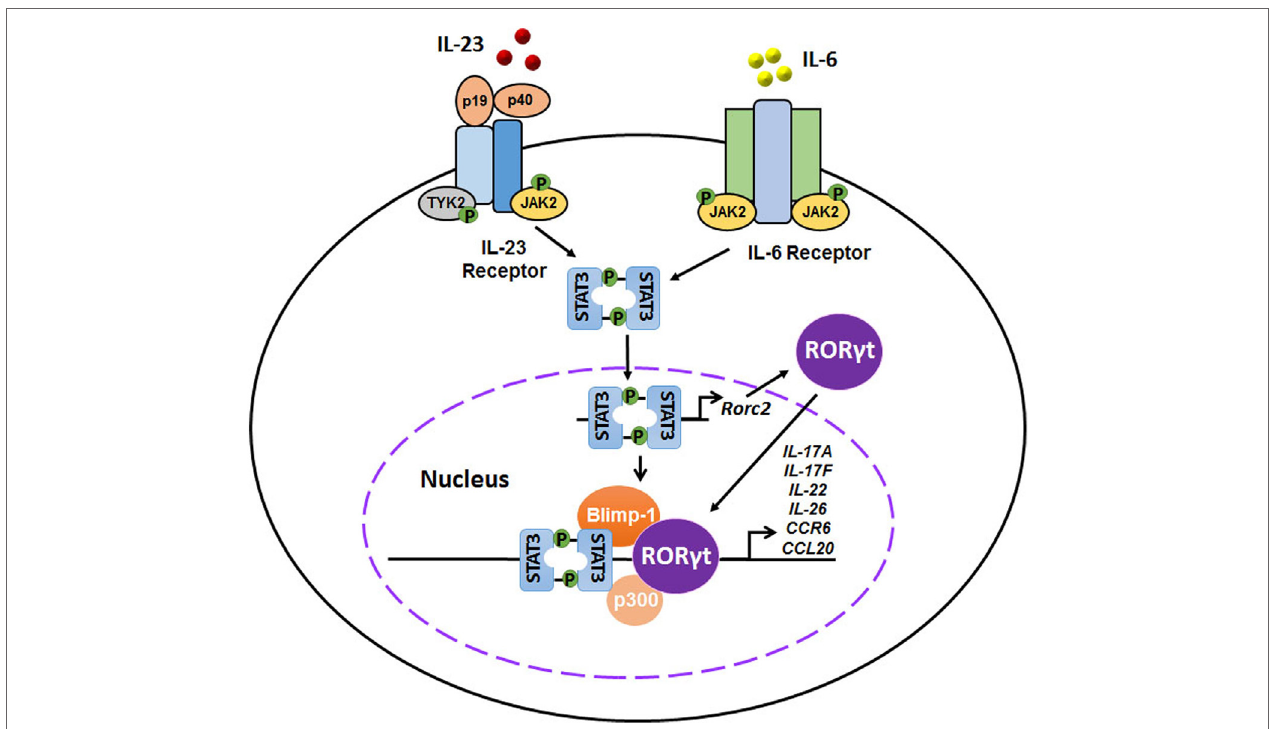
FiGURe 2 | Interplays of interleukin-23 (IL-23), IL-6, signal transducer and activator of transcription 3 (STAT3), and retinoid-related orphan receptor γ t (ROR γ t) in the differentiation of pathogenic T helper 17 (Th17) cells. IL-23 and IL-6 signals activate the JAK–STAT signaling pathway, inducing a strong phosphorylation and dimerization of STAT3. STAT3 homodimers induce the expression and nuclear translocation of ROR γ t, which in turn promotes Th17 responses by activating Th17 gene promoters, including Il17a , Il17f , Il22 , Il26 , Il23r , Csf-2 , Ccr6 , and Ccl20 . In addition, IL-23 signaling-induced transcription factor Blimp-1 enhances pathogenic Th17 function by co-localizes ROR γ t and STAT-3 at Il17a , Il23r , and Csf-2 enhancer